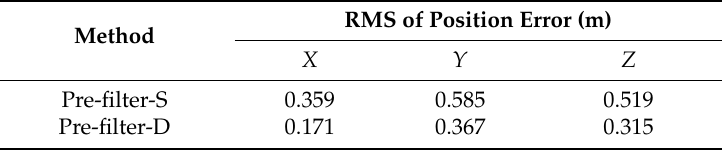
Table 2. RMS of position estimation errors.